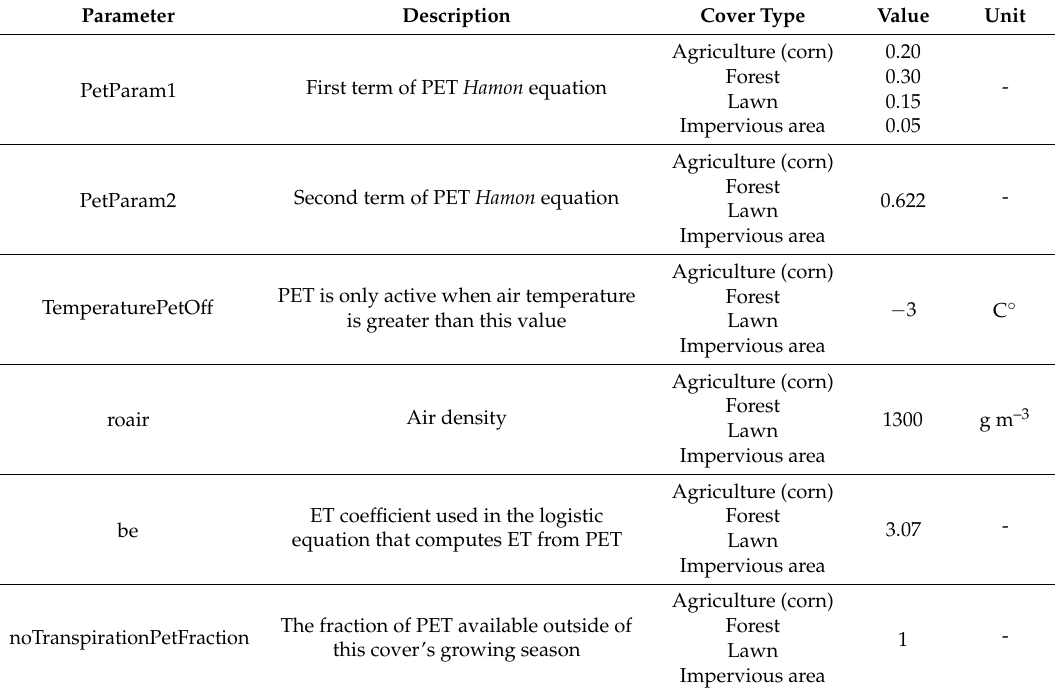
Table 3. Calibrated Potential Evapotranspiration parameters for the base